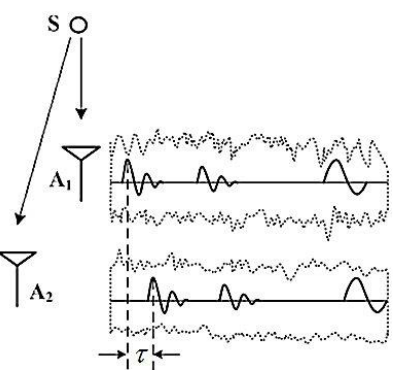
Figure 1. Two signals from the same radiation source are received by the two antennas in the array. A 1 is the antennas A1. A2 is the antennas A2.